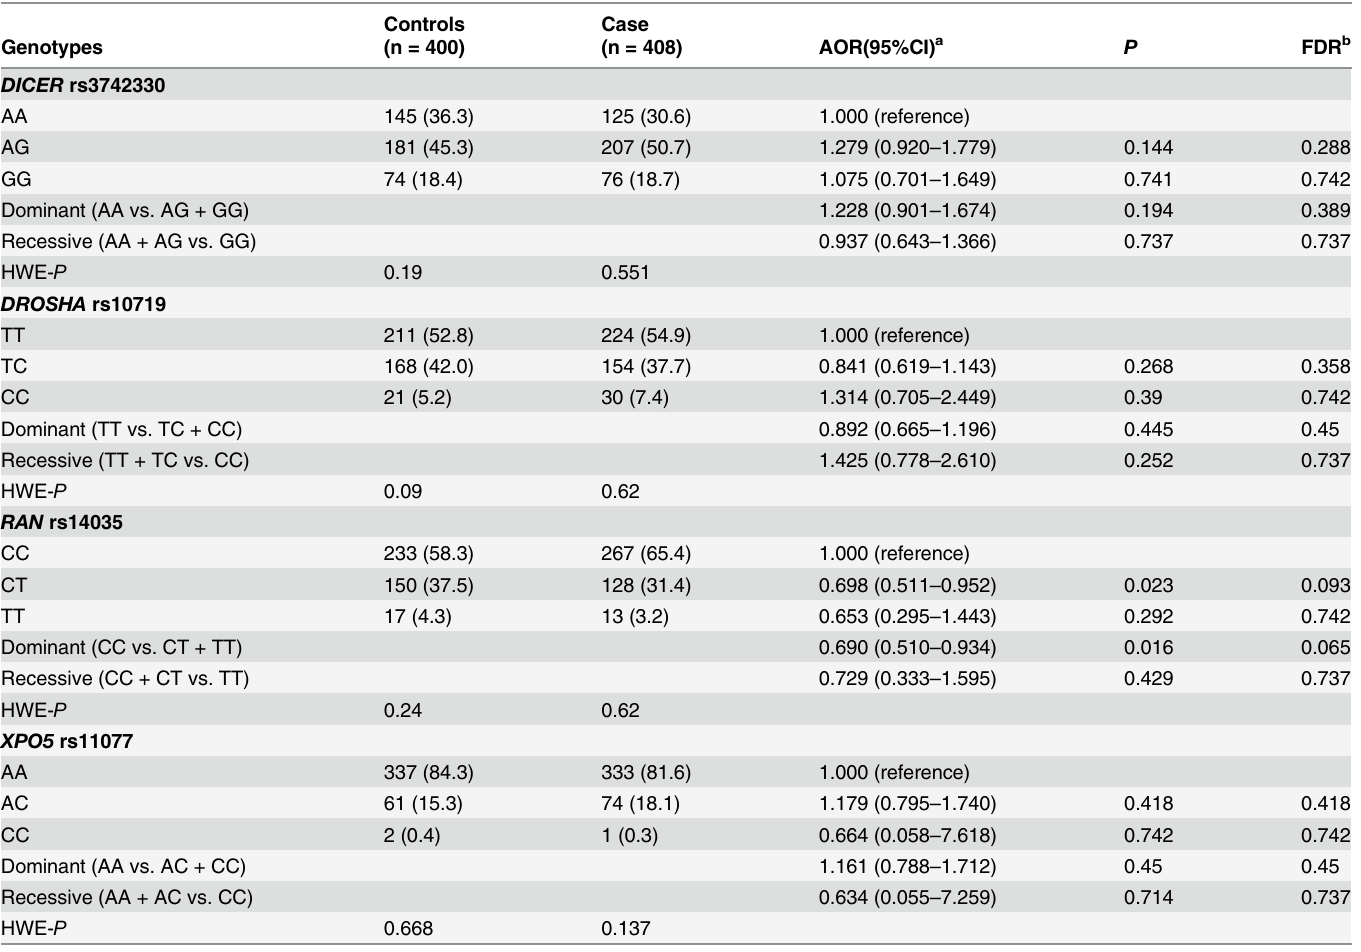
Table 2. miRNA machinery gene genotype frequencies and AORs in colorectal cancer cases and